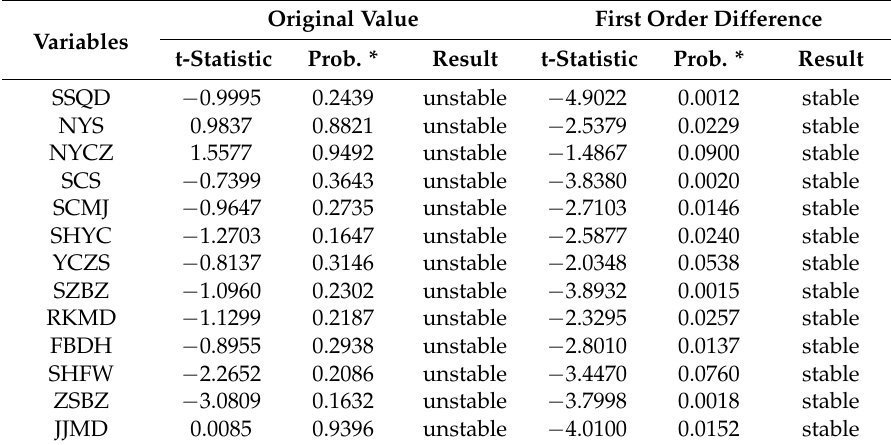
Table 6. Unit root test results of the loss measurement model